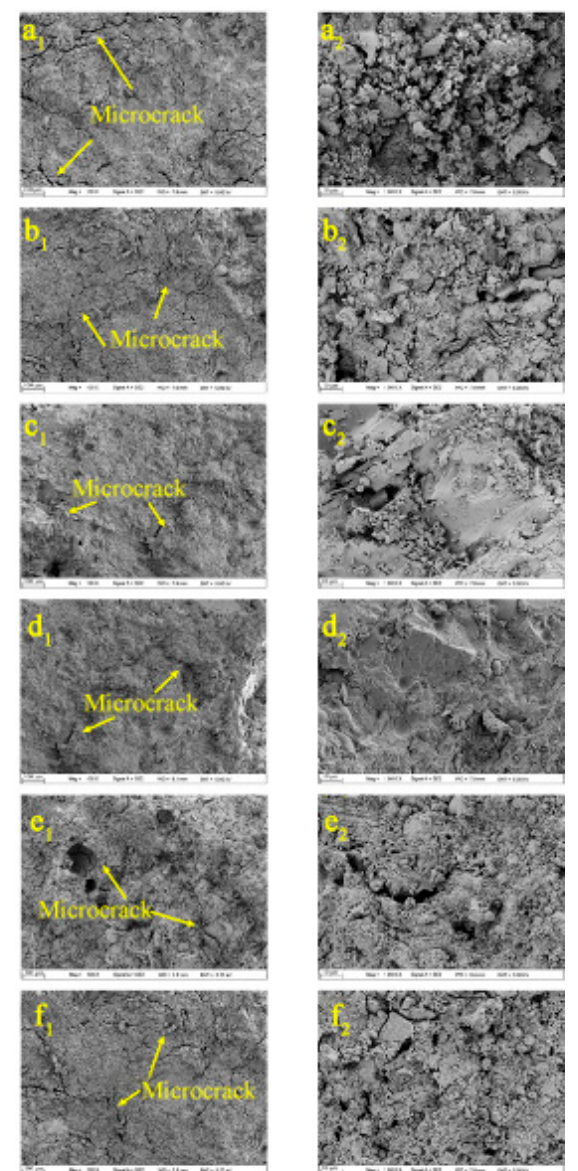
Figure 11. SEM images of SCC coated with ACP under different early curing regimes after the simulated tunnel fire: ( a 1 ) aggregate under 10 °C; ( a 2 ) mortar under 10 °C; ( b 1 ) aggregate under 20 °C; ( b 2 ) mortar under 20 °C; ( c 1 ) aggregate under 30 °C; ( c 2 ) mortar under 30 °C; ( d 1 ) aggregate under 40 °C; ( d 2 ) mortar under 40 °C; ( e 1 ) aggregate under 50 °C; ( e 2 ) mortar under 50 °C; ( f 1 ) aggregate under 60 °C; ( f 2 ) mortar under 60 °C.